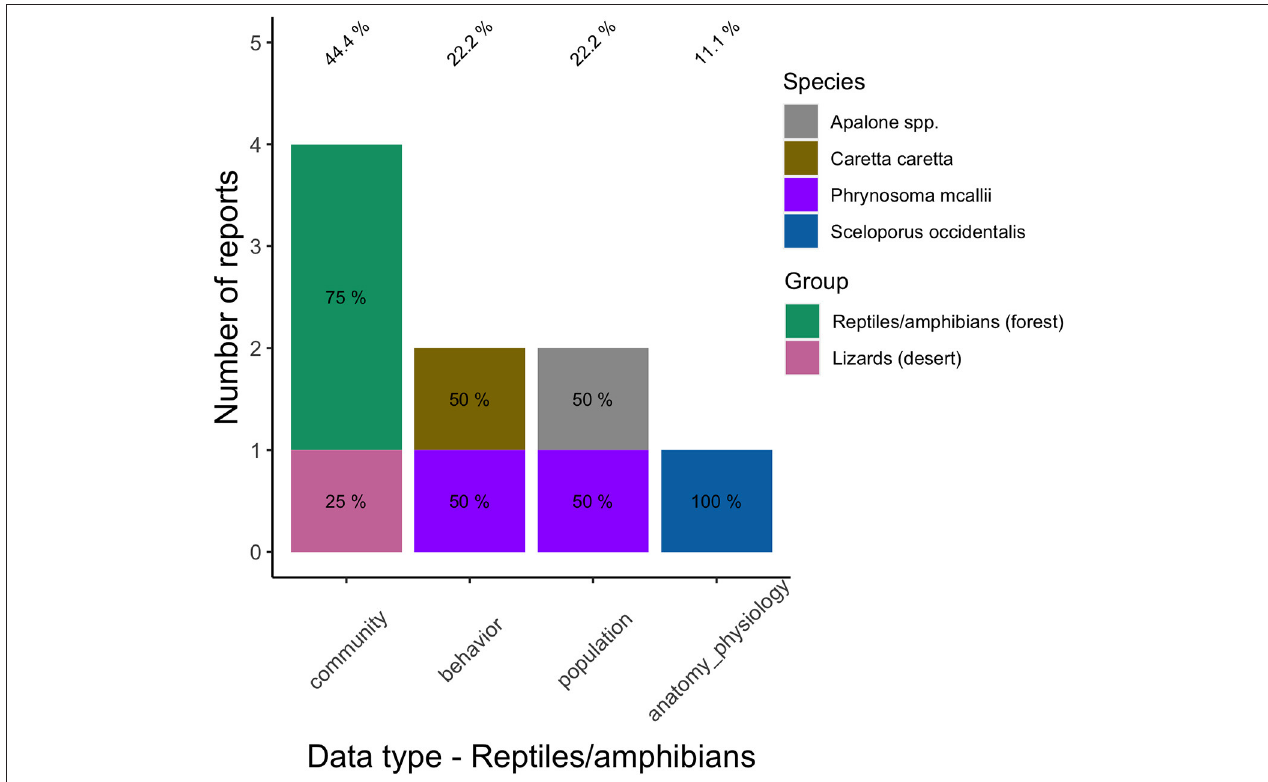
FIGURE 10 | Number of reports that accessed the impacts of off-road vehicle (ORV) use on reptiles/amphibians ( n = 12) across the type of data collected (community, behavior, population, anatomy/physiology). Results are categorized by species or group